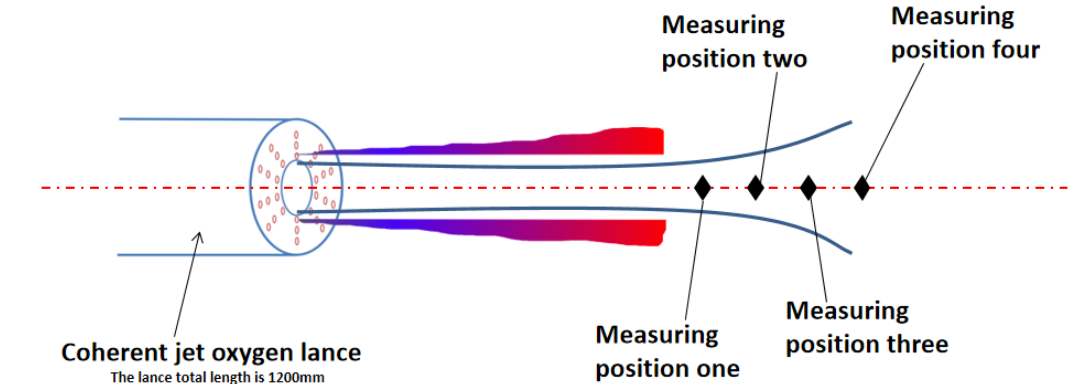
Figure 1. Schematic diagram of the coherent supersonic jet and the experimental measurement principle.